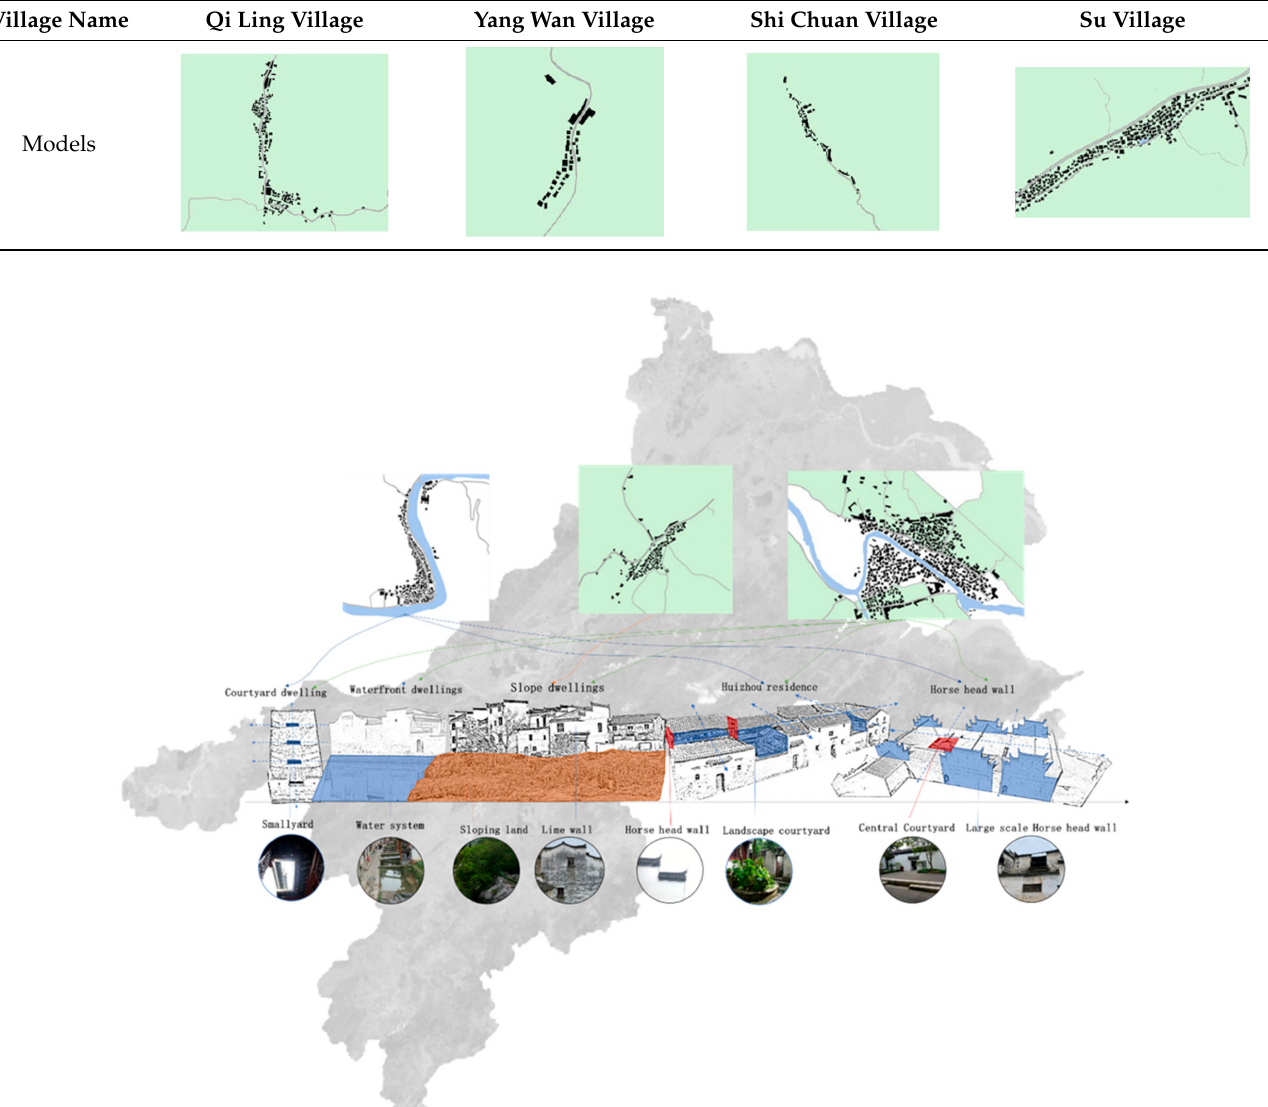
Table 7. Similarities and differences in example of banding form villages: edited by authors.